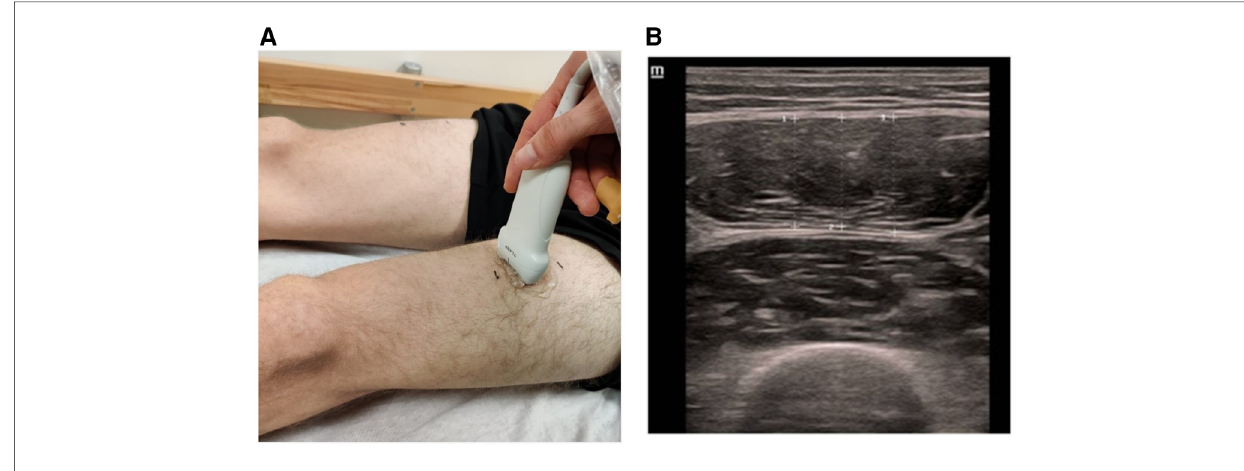
FIGURE 2 Sonography to measure muscle thickness of m. rectus femoris ( A ) and image analysing of three subsequent distances ( B